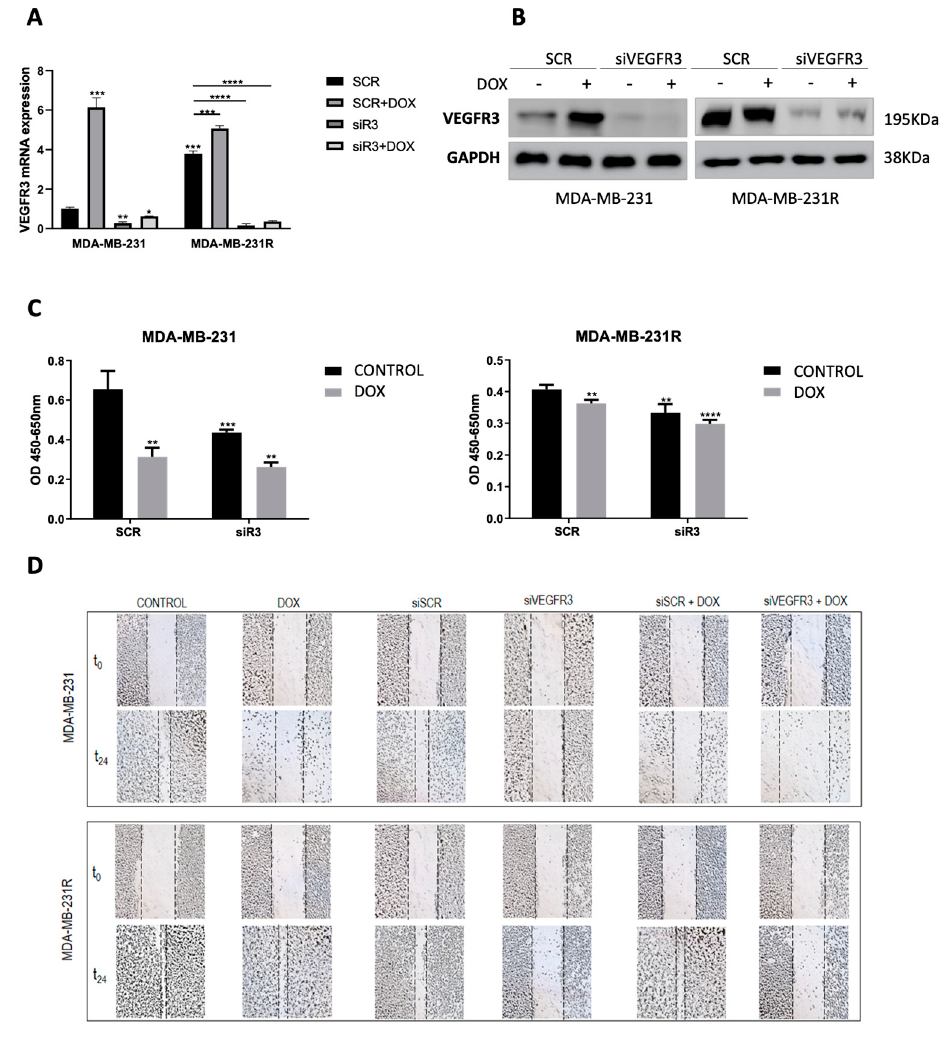
Figure 2. Effect of doxorubicin treatment in MDA-MB-231 cells vs. MDA-MB-231R cells. VEGFR3 mRNA expression after MDA-MB-231 or MDA-MB-231R transfection with silencer control (MDA- MB-231 SCR and MDA-MB-231R SCR) or VEGFR3 silencer (MDA-MB-231 siR3 and MDA-MB-231R siR3) with or without doxorubicin treatment (DOX). Gene expression was evaluated by RT-qPCR, and GAPDH was used as endogenous gene. The statistical analysis was performed by comparing each condition to SCR control in each cell line ( A ). VEGFR3 protein expression was evaluated by Western blot in the same conditions for MDA-MB-231 and MDA-MB-231R cell lines. GAPDH was taken as endogenous control ( B ). Viability of MDA-MB-231 and MDA-MB-231R cells was evaluated